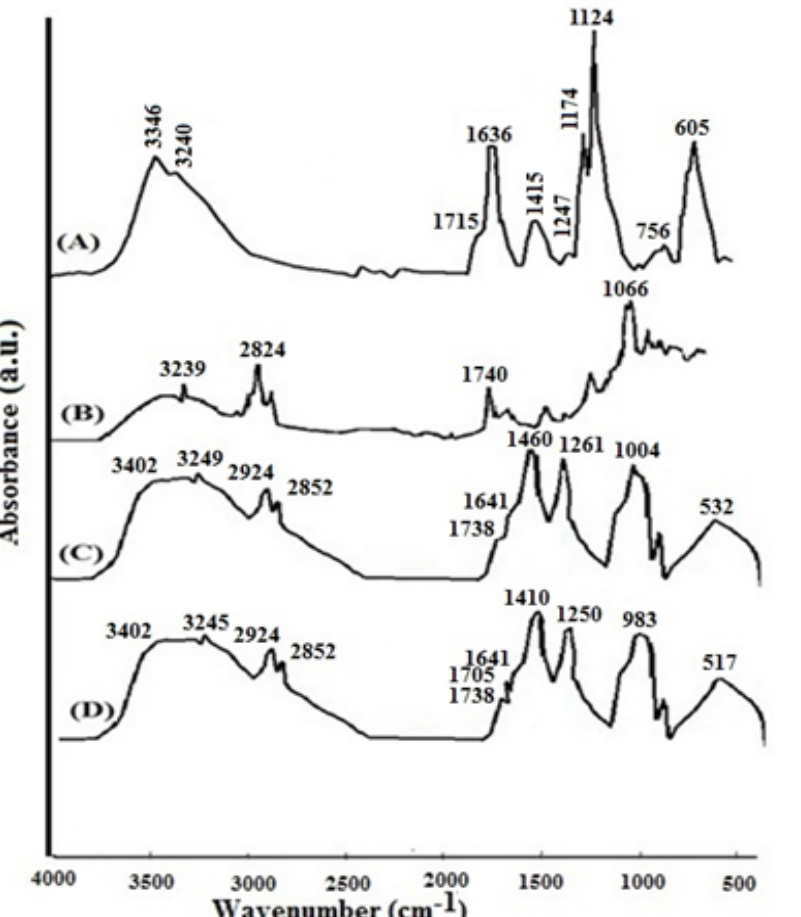
Figure 2. FTIR spectroscopy, ( A ) FTIR spectrum for 14% hydrolyzed protein, ( B ) FTIR spectrum for non-coated nanoliposomes containing 14% hydrolyzed protein, ( C ) FTIR spectrum for 0.5% chitosan-coated nanoliposomes containing 14% hydrolyzed protein, ( D ) FTIR spectrum for 1% chitosan-coated nanoliposomes containing 14% hydrolyzed protein.